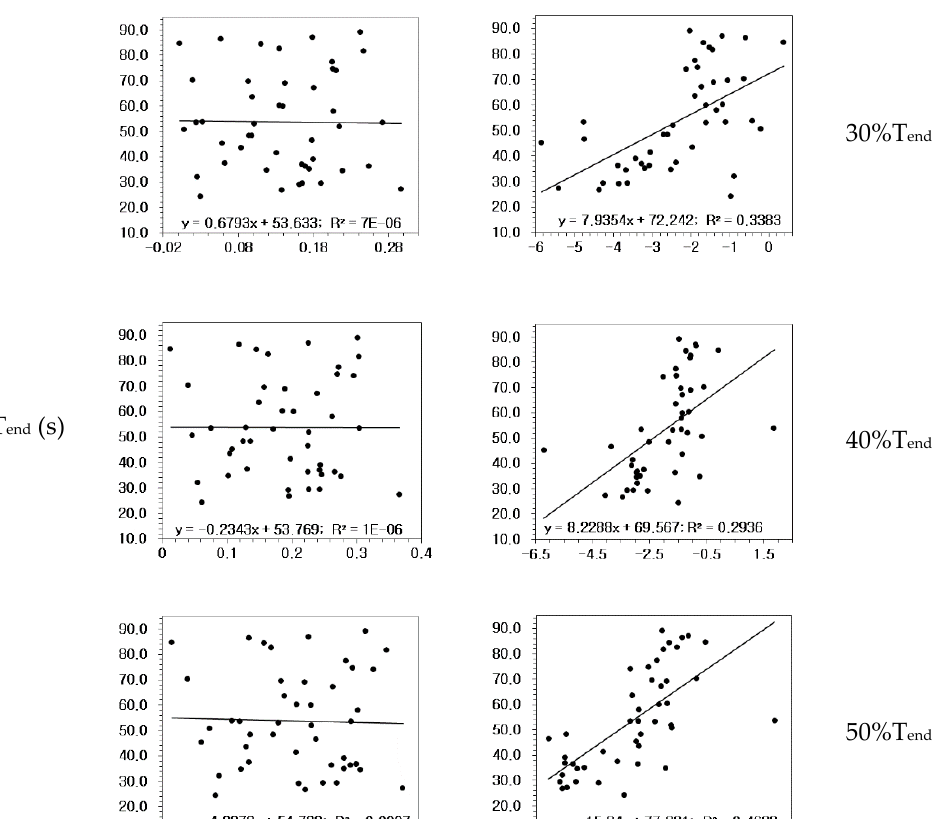
Figure 11. Scatter plots of the area ratio in the column (a) and the slope in the column ( b ) of the H/L-SM against T end.